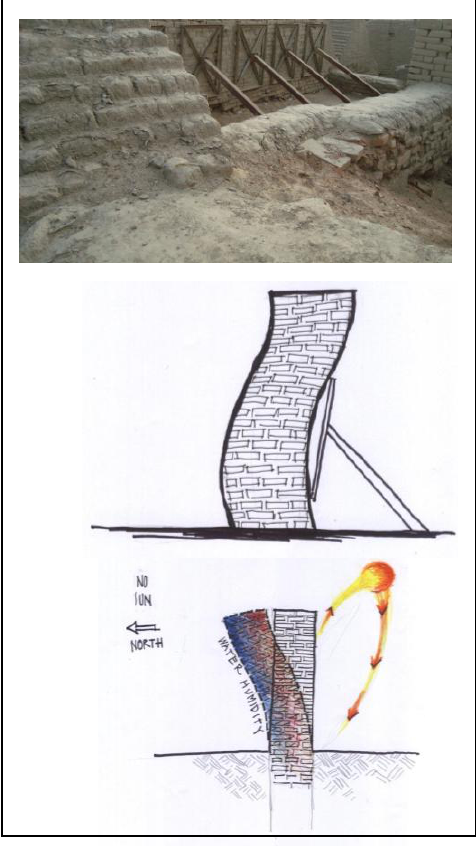
Figure 2a : the exo- skeletal support (30 March, 2012) This is a critical case out of plane wall in DKG-North area. Figure 2b: Exaggerated deformation pattern in the sectional view, along with the support